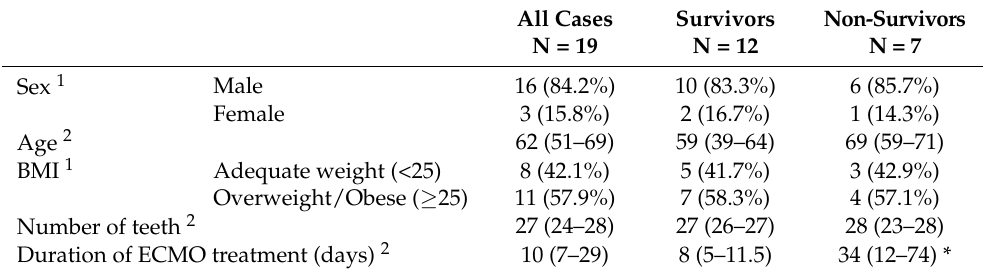
Table 3. Patient characteristics.